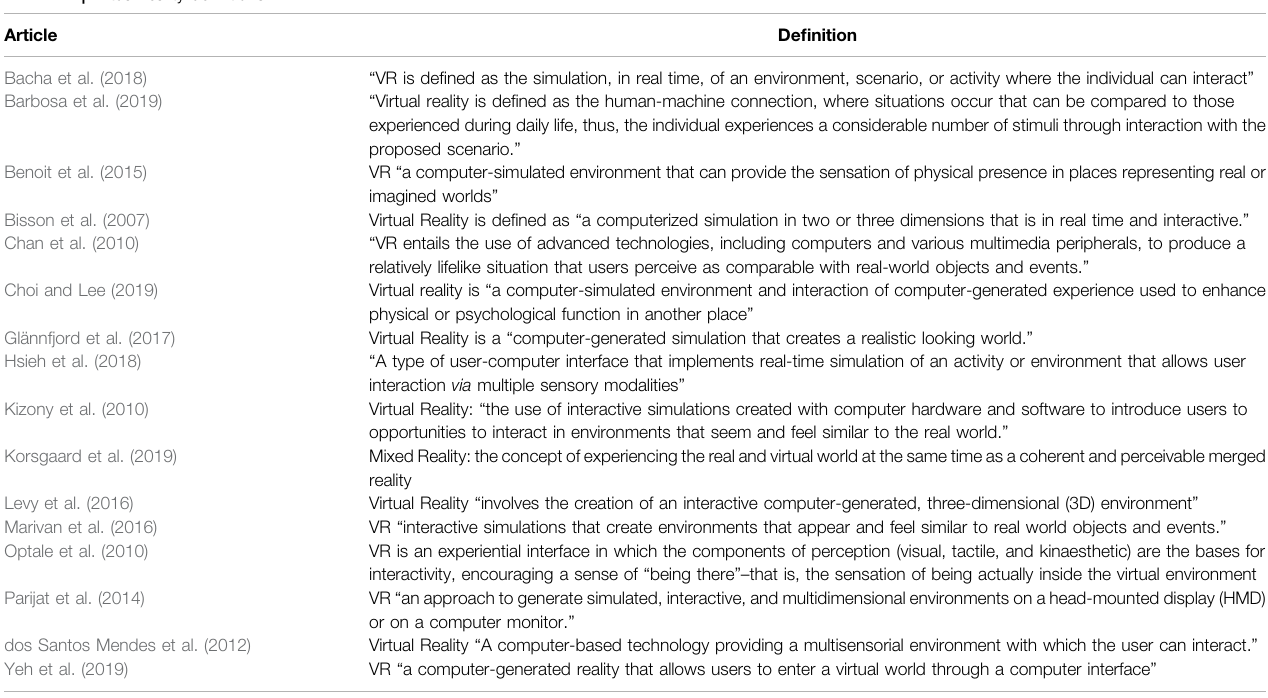
TABLE 4 | Virtual reality de fi